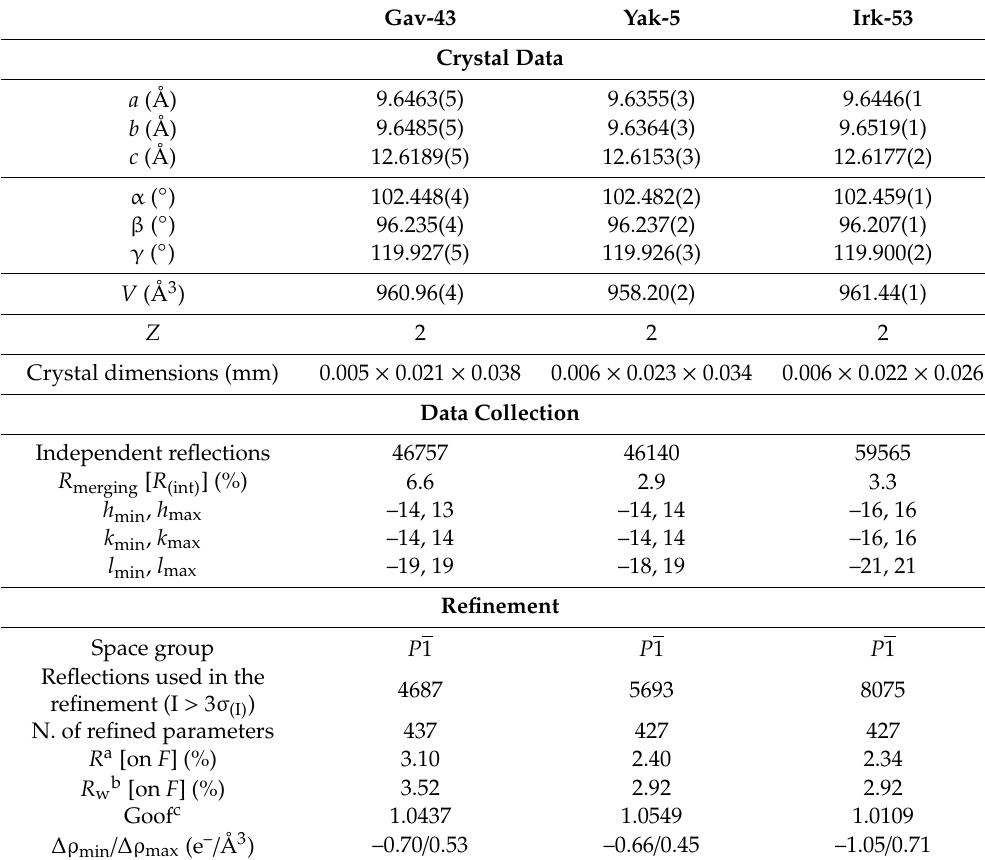
Table 2. Selected data on single crystals, data collection and structure refinement parameters of the studied fedorite